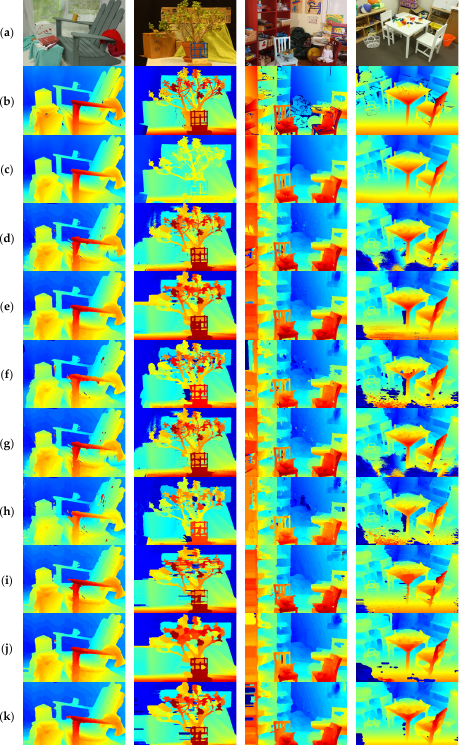
Figure 5. Visual comparison of disparity maps obtained by different algorithms. ( a ) The left scene images selected from the Middlebury version 3 [31] dataset (from left to right): Adirondack, Jade- plant, Playroom, and Playtable. ( b ) Ground-truth disparity maps, ( c ) Disparity maps generated by RTSMNET [25]. ( d ) Disparity maps generated by ISM [15]. ( e ) Disparity maps generated by DDL [4]. ( f ) Disparity maps generated by TPAO [8]. ( g ) Disparity maps generated by IGF [14]. ( h ) Disparity maps generated by ACR-GIF-OW [16]. ( i ) Disparity maps generated by HGIF [20]. ( j ) Disparity maps generated by FASW [21]. ( k )Disparity maps generated by an integration of the proposed